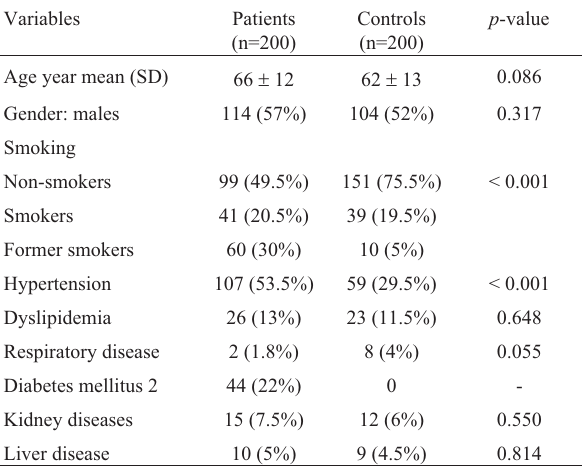
Table 1 - Prevalence of cardiovascular risk factors among all participants included in the study by